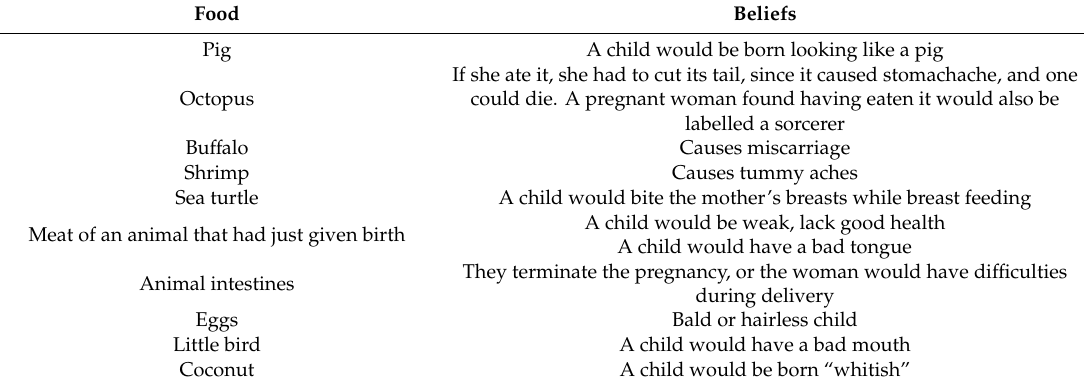
Table 3. List of foods and taboos around food consumption for breastfeeding and pregnant